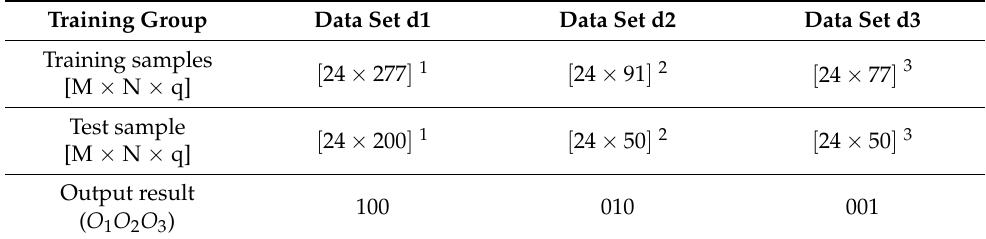
Table 5. The training design of the BP-based FDI model.